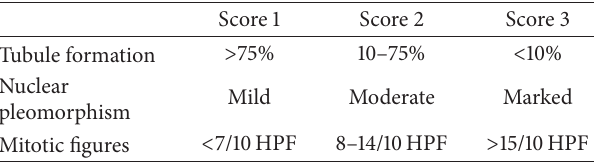
Table 1: Bloom Richardson